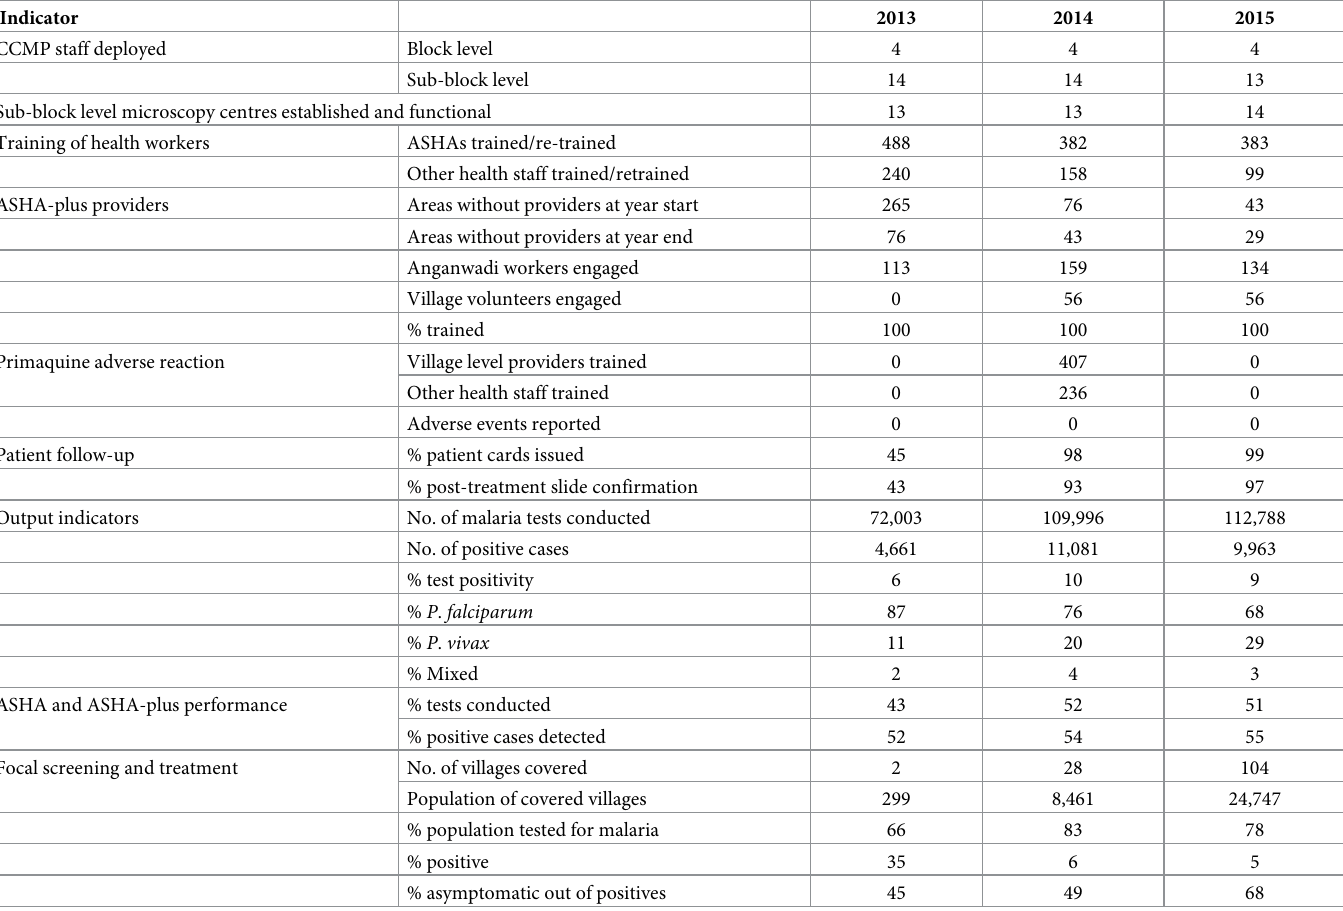
Table 1. Key CCMP inputs, process and output indicators in the intervention